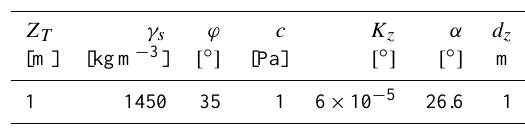
Table 1. Soil parameters, slope degree and initial condition used to generate Fig.